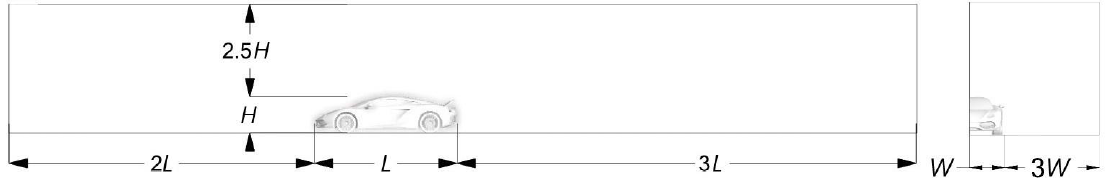
Figure 19. The geometry of the analyzed car: ( a ) Without the FDDG, different views; ( b ) With the FDDG marked in magenta, cross-section view. Domain size is shown in Figure 20. Velocity was specified at the inlet surface with a turbulence intensity of 5% and a length scale of 5 mm. Moving wall boundary conditions were applied to the ground and car wheels. Half of the geometry was modelled with a symmetry boundary condition. The same boundary condition was also applied to the side and top surfaces. Constant gauge static pressure of 0 Pa was applied at the outlet surface.